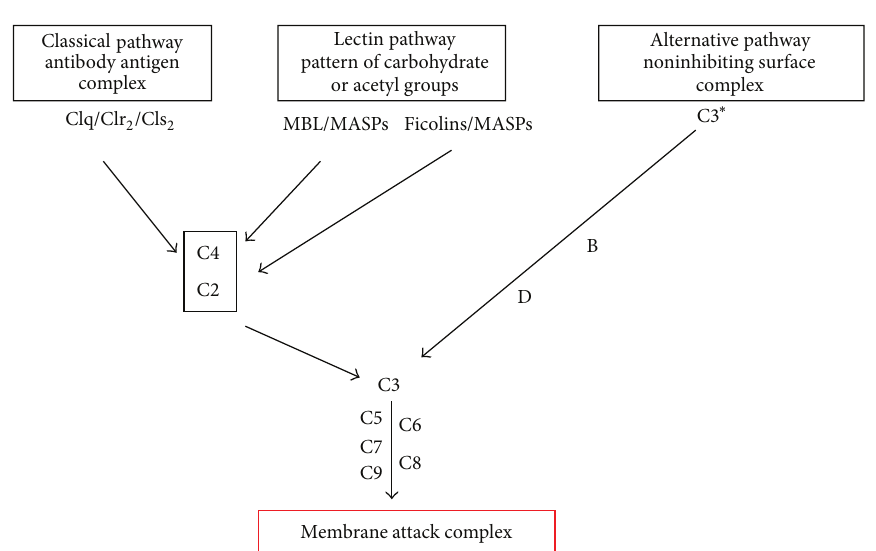
Figure 1: Complement activation pathways. Classical, lectin, and alternative pathways are activated in different ways and culminate with the direct destruction of pathogens via the membrane attack